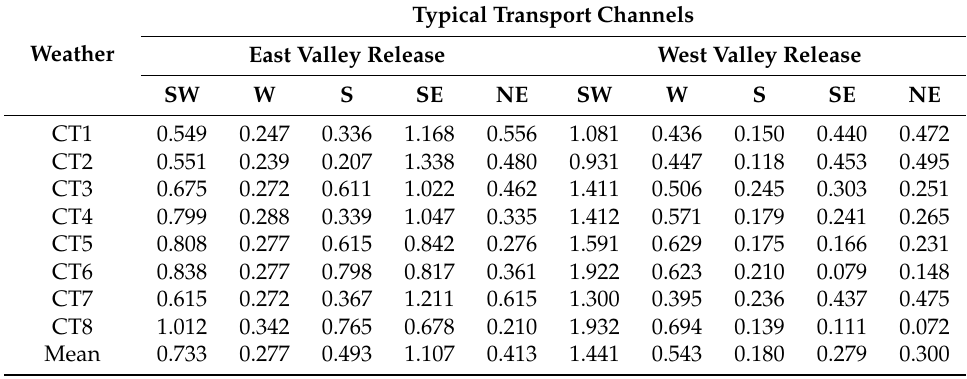
Table 1. Percentage of particles passing through the five typical transport channels under different circulation types and average states (units: %/km).